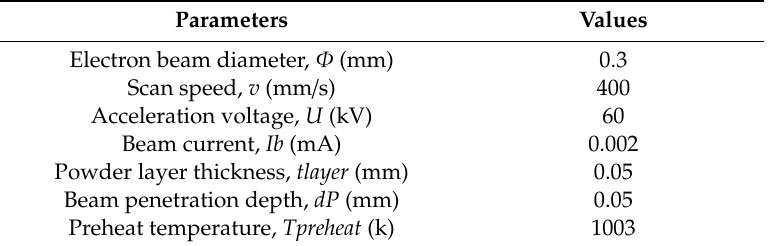
Figure 7. EBM printed thin-walled parts for model validation. Table 4. Parameters used in the simulations and for producing the EBM parts